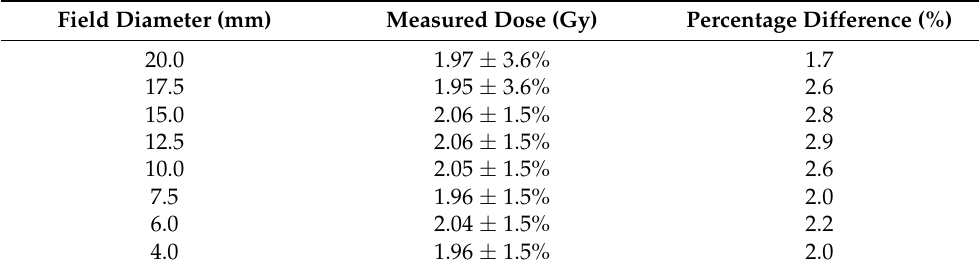
Table 6. TLD-measured doses and the percentage difference relative to the prescribed